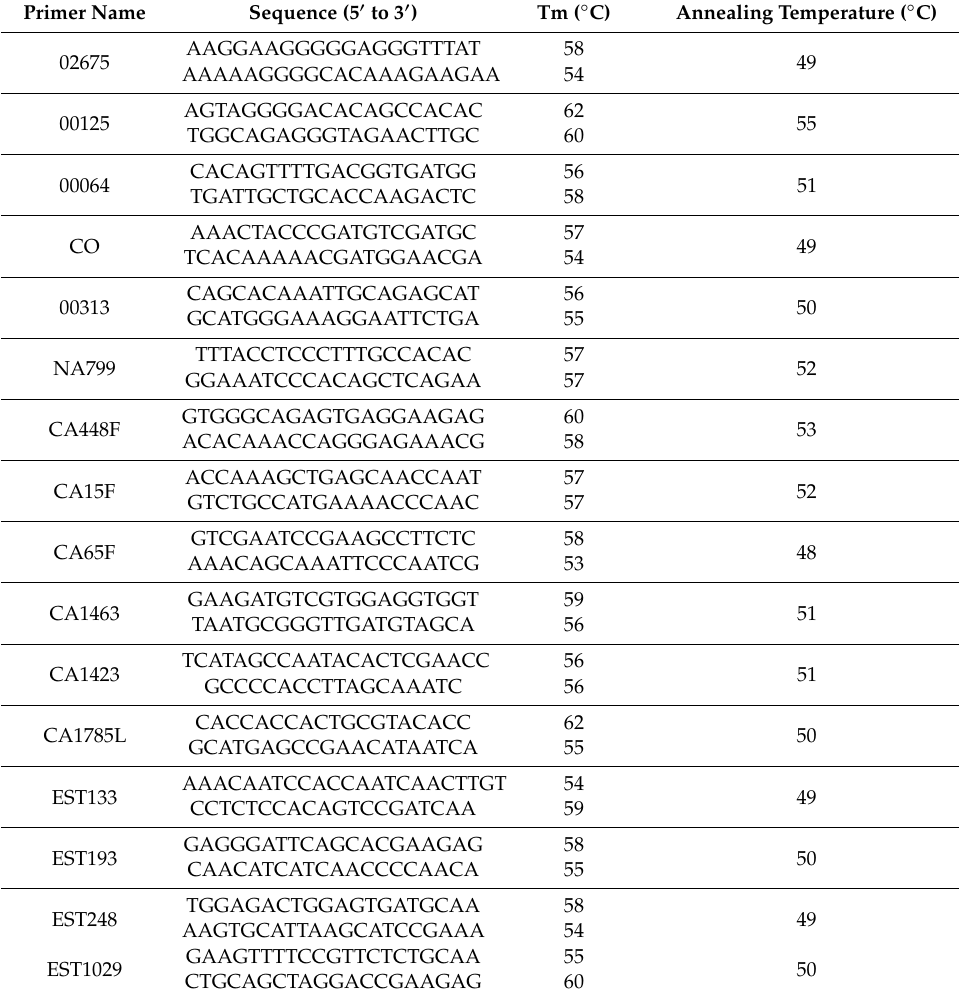
Table 1. Primer pairs used for analyses that yielded reproducible polymorphic bands throughout the